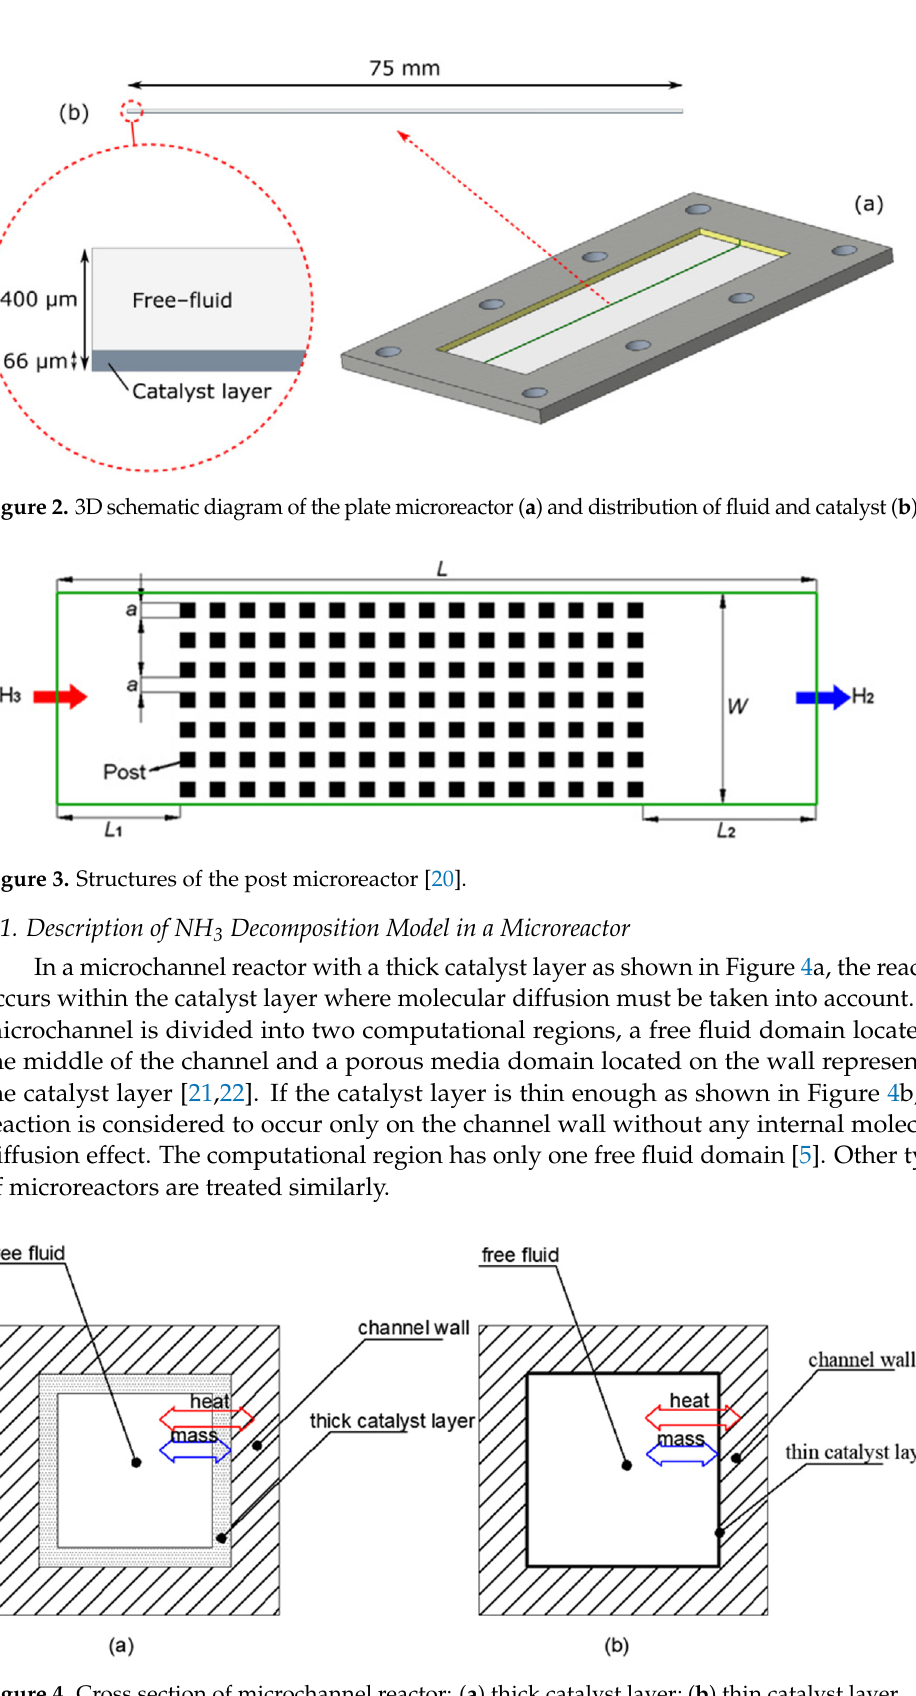
Figure 2. 3D schematic diagram of the plate microreactor ( a ) and distribution of fluid and catalyst ( b ) [19].